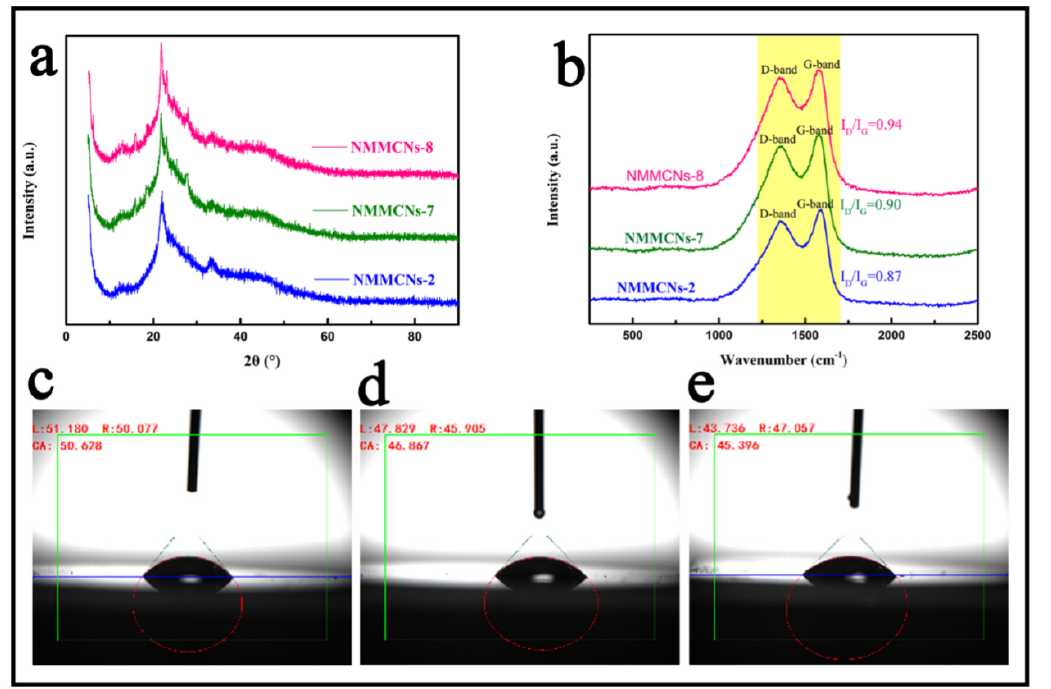
Figure 8. XRD patterns ( a ) and Raman spectra ( b ) of NMMCNs-2, NMMCNs-7 and NMMCNs-8 and ( c ), ( d ) and ( e ) correspond to the contact angles of NMMCNs-2, NMMCNs-7 and NMMCNs-8, respectively.